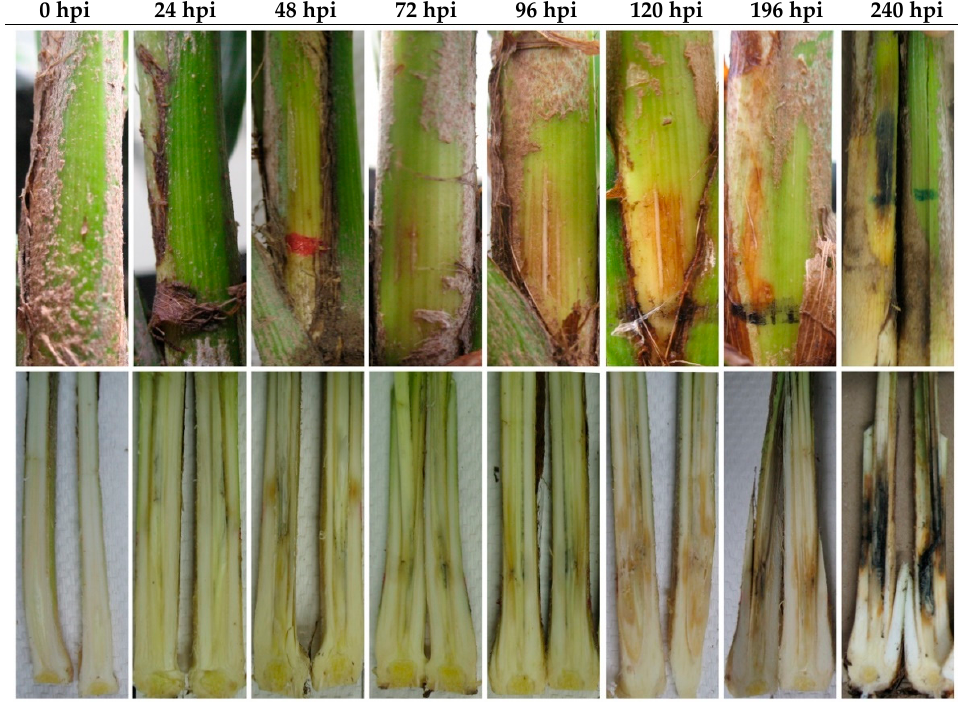
Figure 4. Disease progression in oil palm hybrid O × G seedlings inoculated using local infiltration of a T. paradoxa suspension of 1 × 10 6 endoconidia mL − 1 . The externally and internally. The external damage (upper panel) and internal damage (bottom panel) were recorded at different hours post-infection